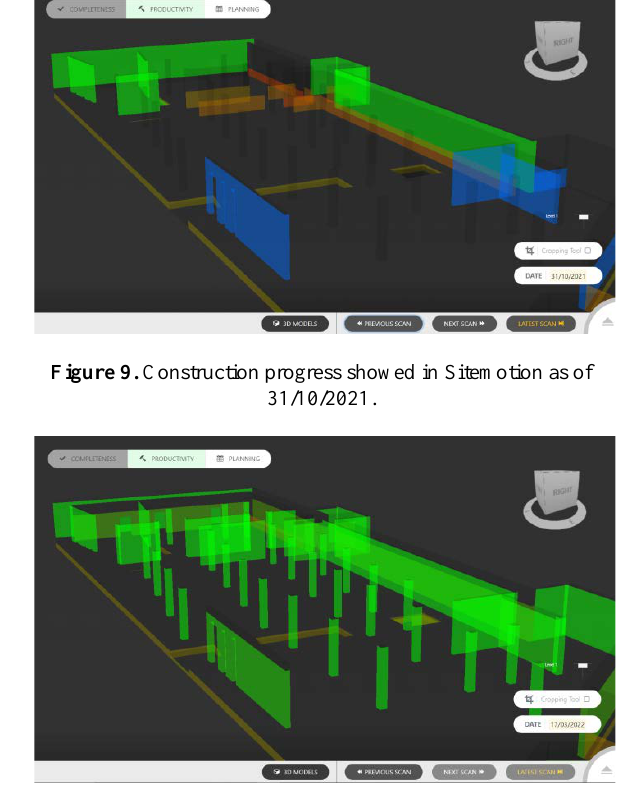
Figure 10. Construction progress showed in Sitemotion as of